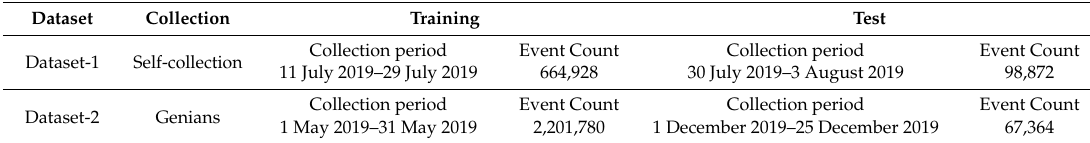
Table 5. LOF based single suspicious event analysis results.